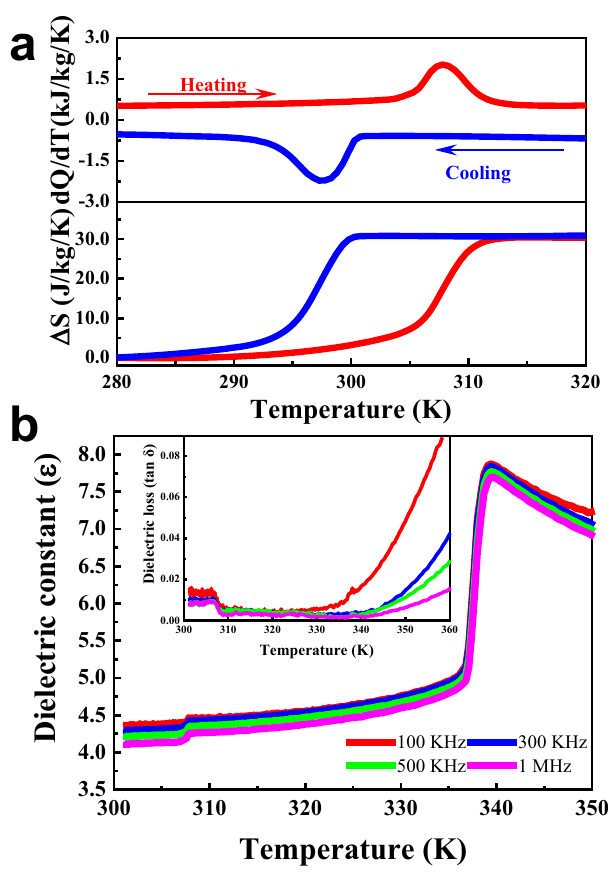
Fig. 2 Phase transitions in 1. a Top panel, heat fl ow dQ / dT on heating (red) and cooling (blue) across the FE – PE transition. Bottom panel, the resulting temperature dependence entropy change Δ S . b Temperature-dependent relative permittivities. Inset is the temperature-dependent dielectric loss (tan δ ).